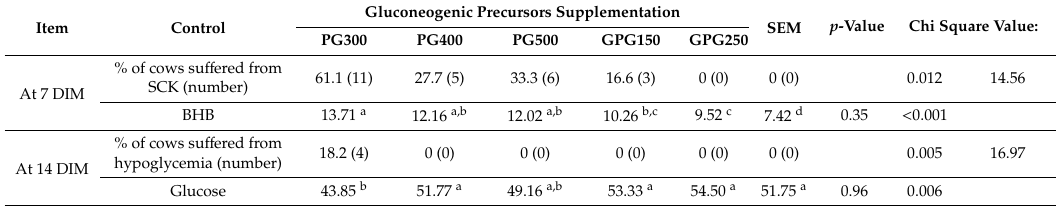
Table 5. E ff ect of di ff erent treatment regimens on serum levels of BHB and glucose (mg / dL) as well as the percentage of cows su ff ered from subclinical ketosis (SCK) ( > 12.49 mg / dL) or hypoglycemia ( < 40 mg / dL).